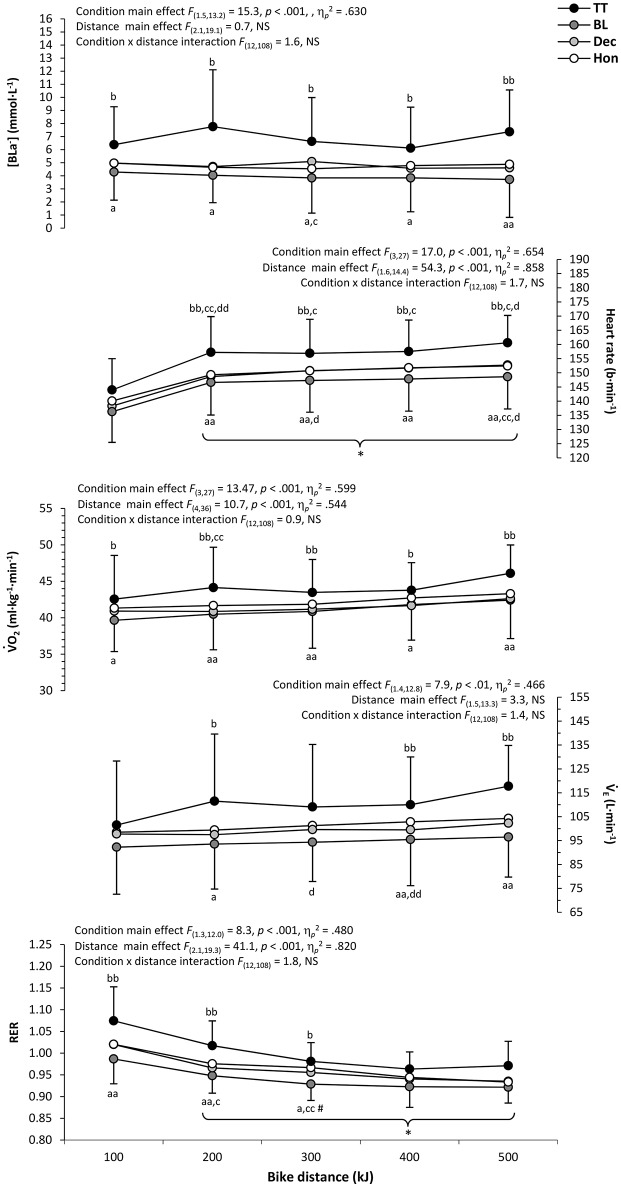
Mean ± SD physiological responses for each 100 kJ cycling section. Significantly different from; TT, ap < 0.05, aap < 0.01; BL, bp < 0.05, bbp < 0.01; DEC, cp < 0.05, ccp < 0.01; HON, dp < 0.05, ddp < 0.01; initial value, *p < 0.05; previous value, #p < 0.05 (parentheses indicate significance in all conditions).